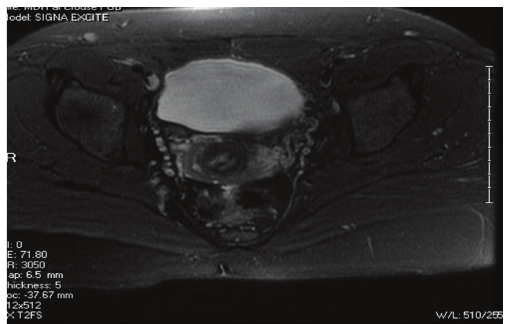
Figure 3: Axial view; note the cervices and two